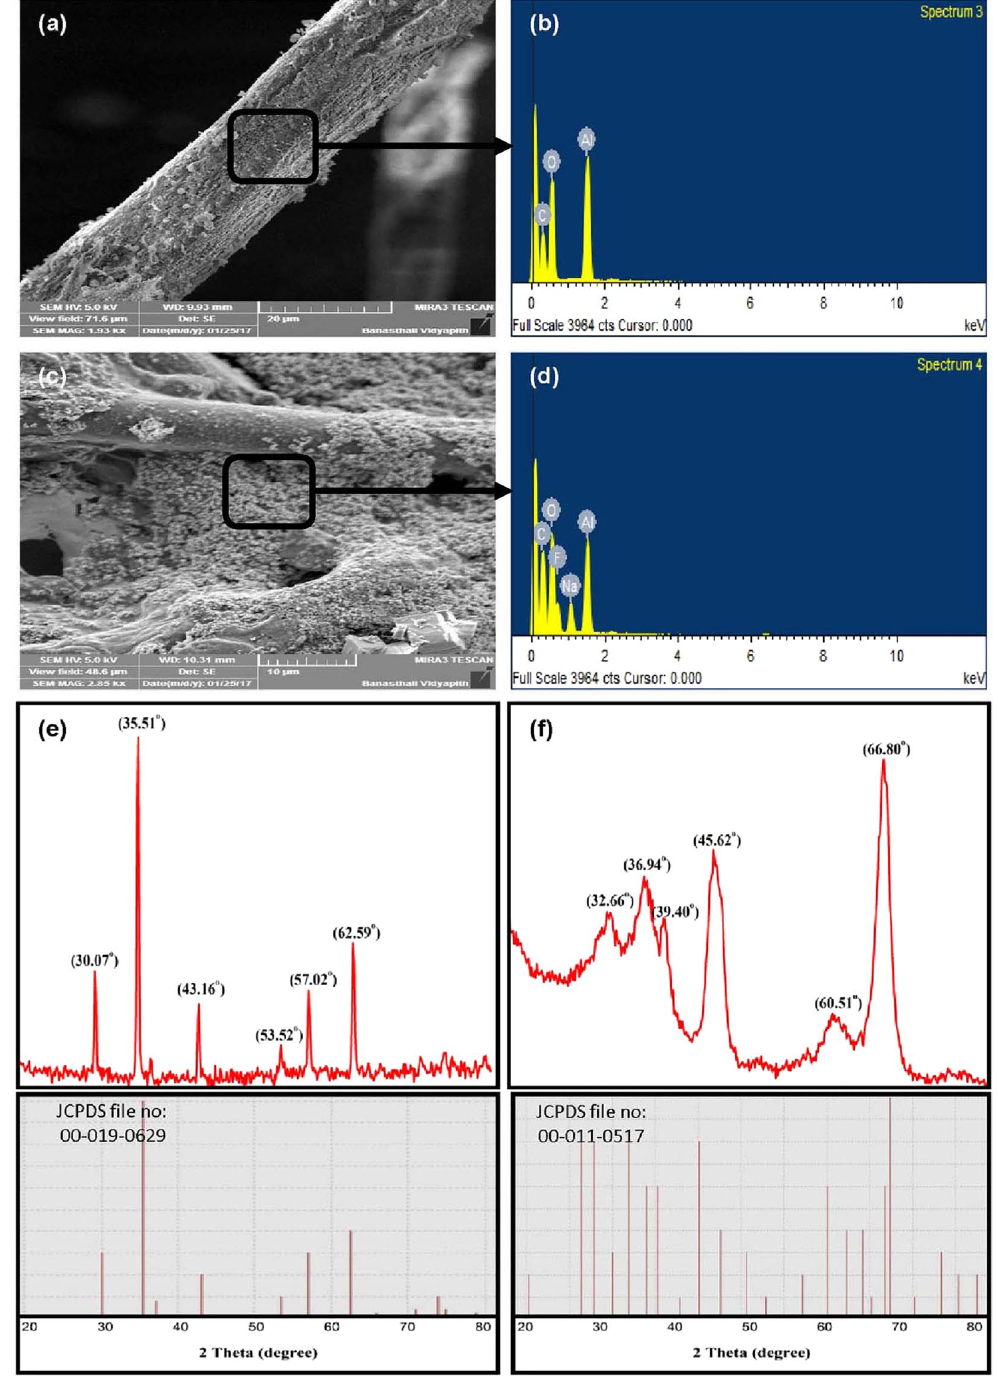
Figure 2. FESEM and EDX spectrum of ( a ) and ( b ) the Al-PUF tea bag, ( c ) and ( d ) the Al-PUF tea bag after F adsorption, and ( e ) and ( f ) shows XRD patterns of Fe 3 O 4 NPs and Al 2 O 3